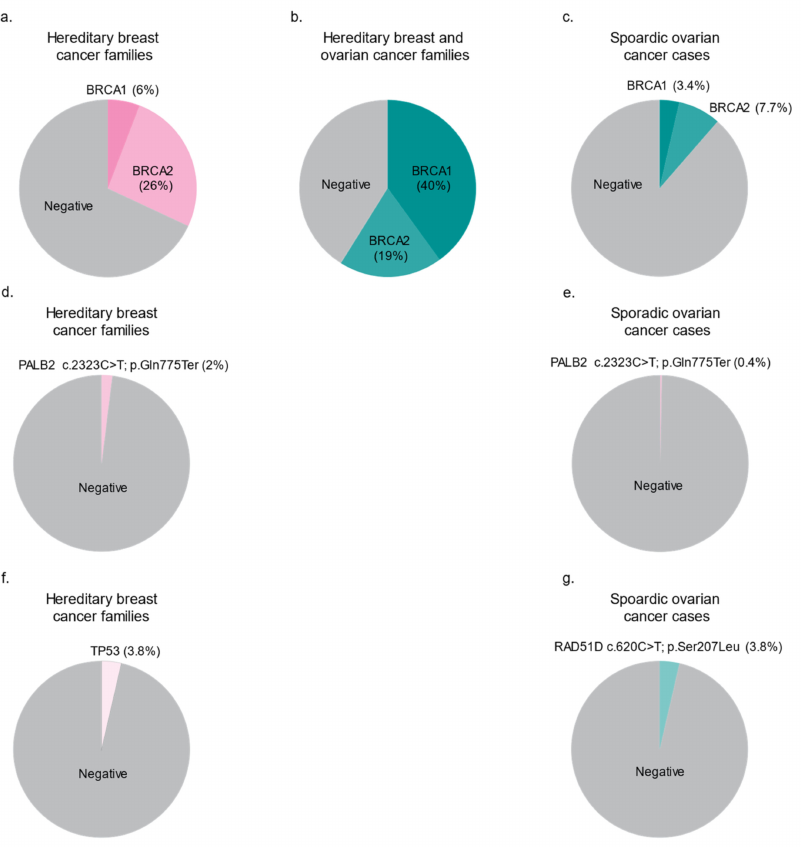
Figure 1. Representative carrier frequencies of frequently occurring pathogenic variants in HBC and HBOC predisposing genes in French Canadians of Quebec. Distribution of BRCA1 and BRCA2 variants in hereditary breast cancer syndrome ( a ), hereditary breast and ovarian cancer syndrome ( b ), and sporadic ovarian cancer cases ( c ). Carrier frequency of a PALB2 variant ( d ) and TP53 variants ( f ) in hereditary breast cancer. Carrier frequency of a PALB2 variant ( e ) and a RAD51D variant ( g ) in sporadic ovarian cancer cases. Data from [35] where 169 cancer families were analyzed. Selected variants in BRCA1 ( n = 11) and BRCA2 ( n = 9) were assessed in this study.Data from [39] where 439 sporadic ovarian cancer cases were analyzed. Selected variants in BRCA1 ( n = 2) and BRCA2 ( n = 4) were assessed in this study. Data from [40] where 48 hereditary breast cancer families and 238 sporadic serous ovarian cancer cases were analyzed. One PALB2 variant (c.2323C > T; p.Gln775Ter) was assessed in this study. Data from [41] where 52 hereditary breast cancer families were analyzed. Targeted sequencing of TP53 exons and splice sites was assessed. Data from [42] where 341 sporadic high-grade serous ovarian cancer cases were analyzed. One RAD51D variant (c.620C > T; p.Ser207Leu) was assessed in this study. Sporadic ovarian cancer cases are all derived from the same study group